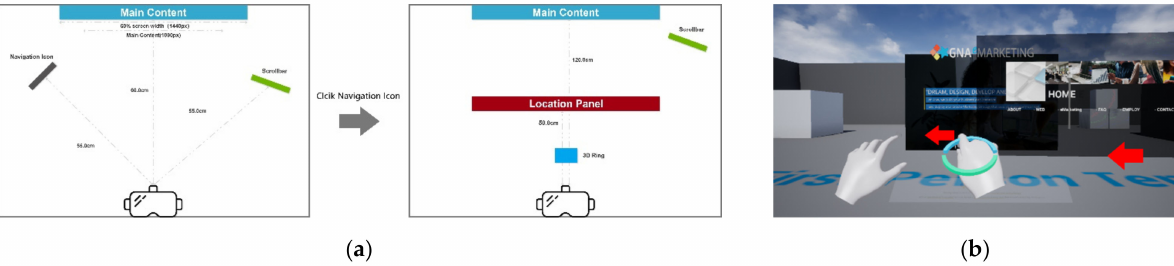
Figure 11. Navigation design: ( a ) Navigation concept; ( b ) Developing screenshot (switching different panels).